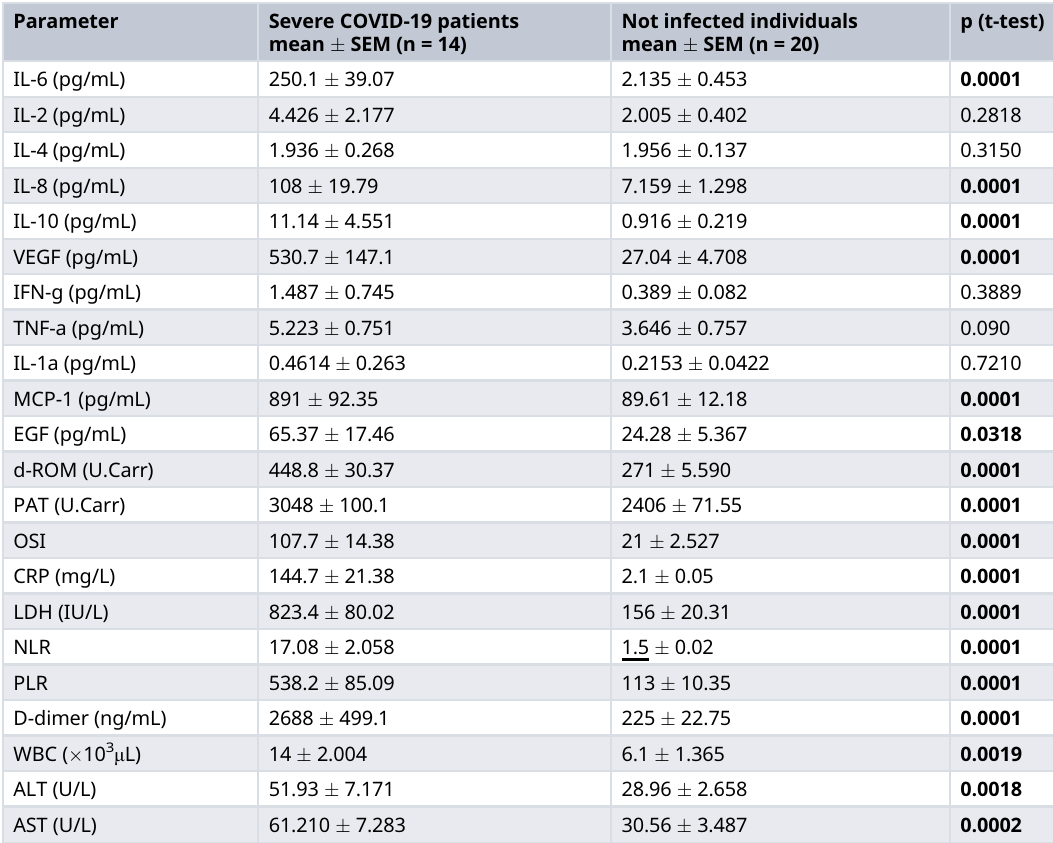
Table 1. Laboratory findings in severe COVID-19 patients and non-infected individuals expressed as mean (cid:1) SEM.